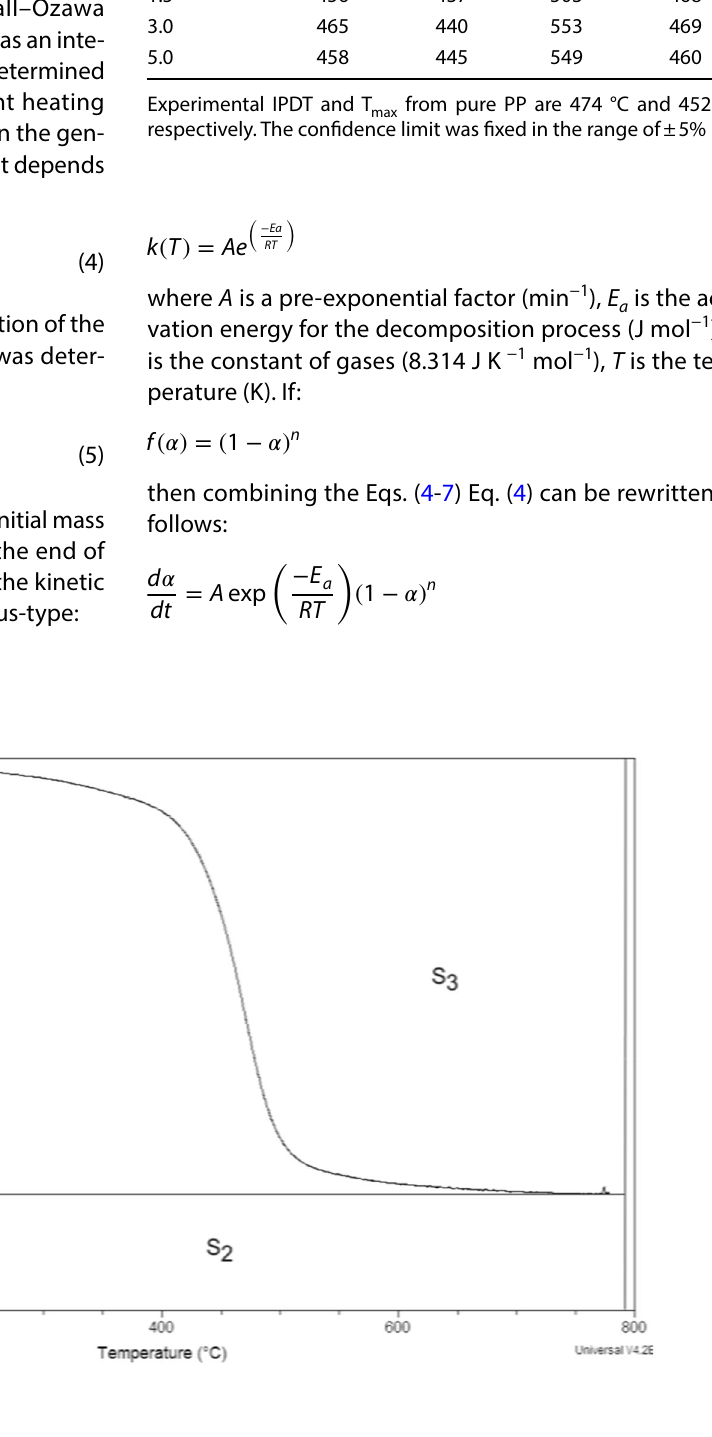
Table 1 Integral procedure decomposition temperature (IPDT) and maximum decomposition temperature (T based nanocomposites at 10 °C.min